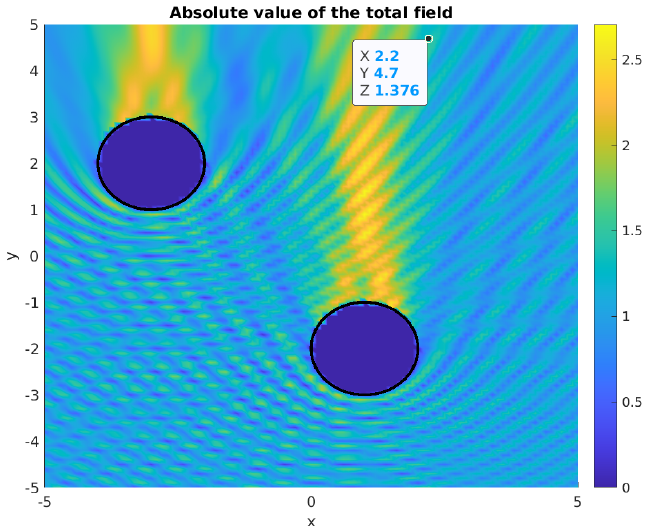
Figure 1. Absolute value of a full wave in a simulation with given obstacles. An upward planar incident wave was applied with k = 4 π